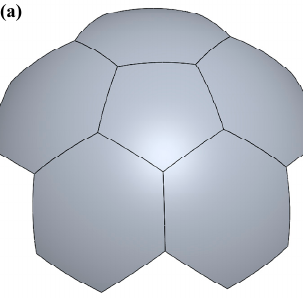
Figure 3. ( a ) Schematic diagram of a 6-lens array; ( b ) Assembled 6-lens array.